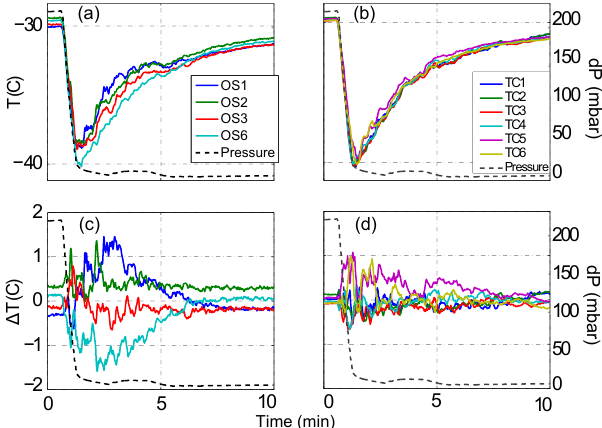
Figure 10. Temperature non-uniformities following an adiabatic pressure reduction during CLOUD9 at − 30 ◦ C in (a) the vertical direction (OS) and (b) the horizontal direction (TC). Panels (c, d) show the residuals from the mean temperatures in the vertical and horizontal directions, respectively. The relative air pressures are shown by dashed curves. Compared with operation under equilib- rium conditions (Fig. 6), larger non-uniformities of up to ± 1.5 ◦ C in the vertical direction and ± 1 ◦ C in the horizontal direction are present, while the chamber returns to its equilibrium temperature with a time constant of about